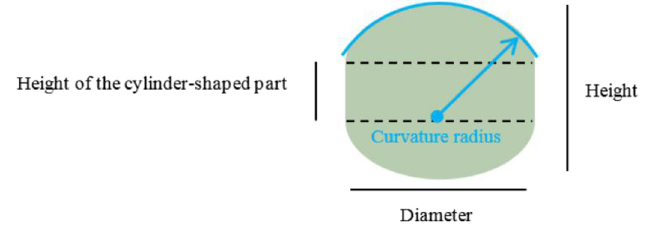
Fig. 1. Geometry of the pellet. Table 1. Initial properties of the pellet.